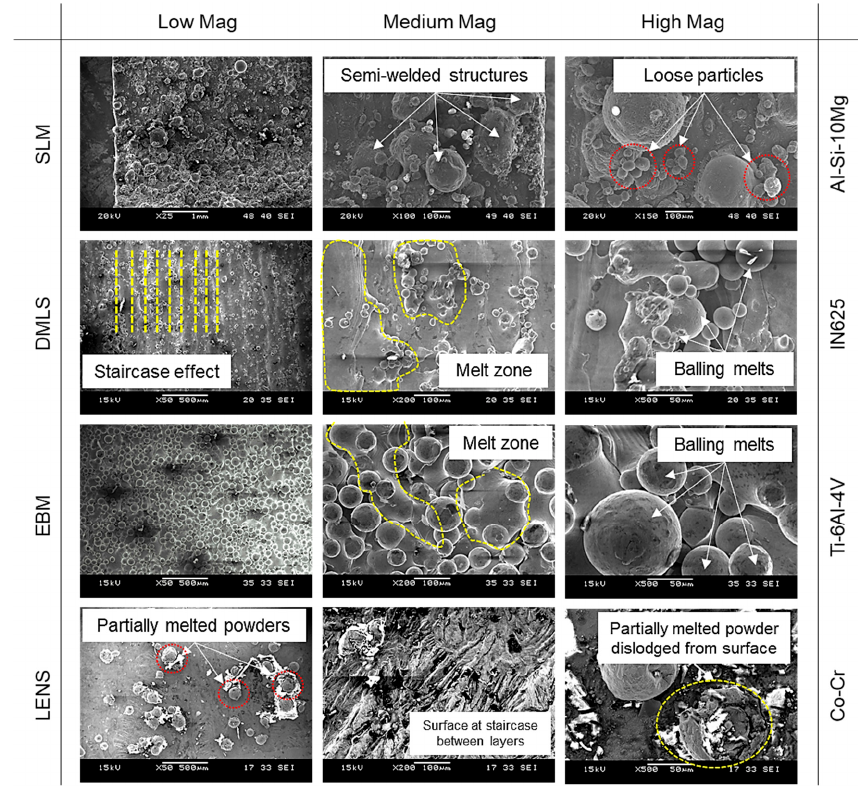
Figure 3. Surface morphology of as-built AM